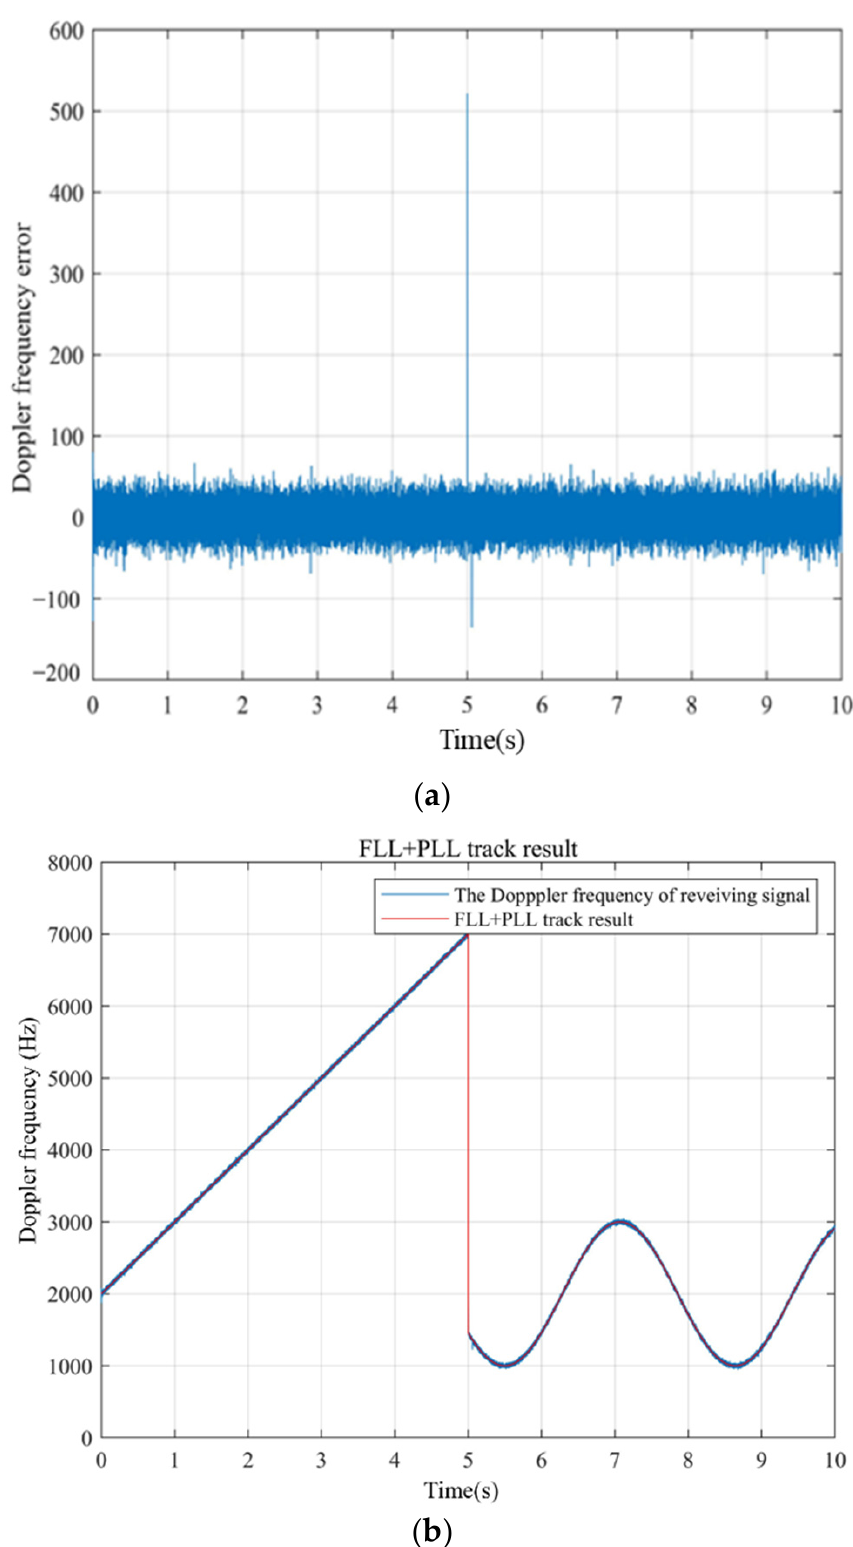
α β= Figure 15. The switching time when α : β = 0.1 : 0.9 and C / N 0 = 55 dB-Hz. ( a ) the Doppler frequency and C/N0 = 55 dB-Hz. ( a ) the Doppler frequency Figure 15. The switching time when : 0.1: 0.9 error, and ( b ) the Doppler frequency error , and (b) the Doppler frequency measurement